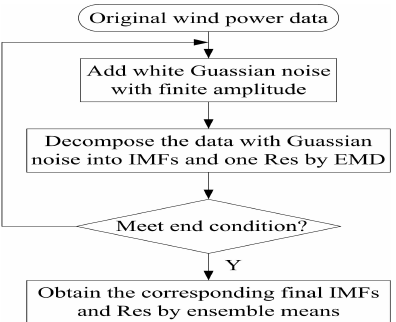
Figure 2. The working flowchart of ensemble empirical mode decomposition